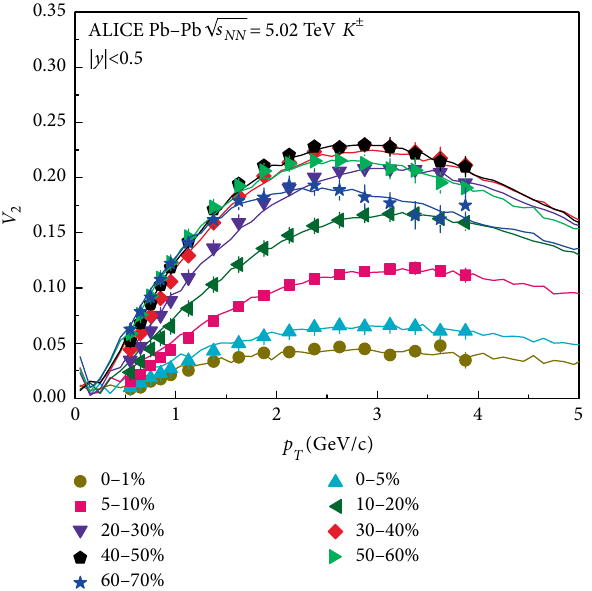
of Λ + Λ for a given 2 (𝑝 푇 )